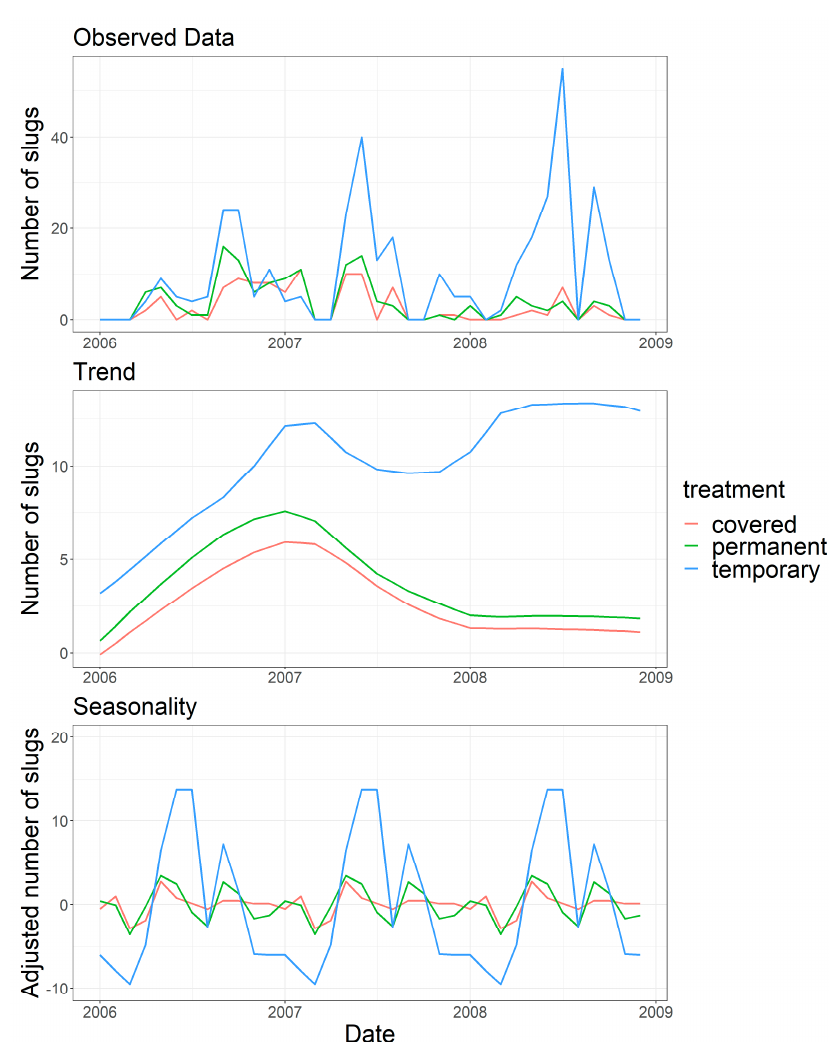
Figure 4. The numbers of Deroceras reticulatum collected from traps at a grassland site analysed by Seasonal Decomposition of Time Series by Loess (STL).